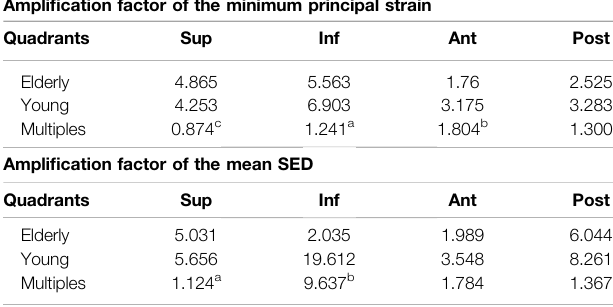
TABLE 9 | The ampli fi cation factors of minimum principal strain and mean SED in the elderly and the young. Ampli fi cation factor of the minimum principal